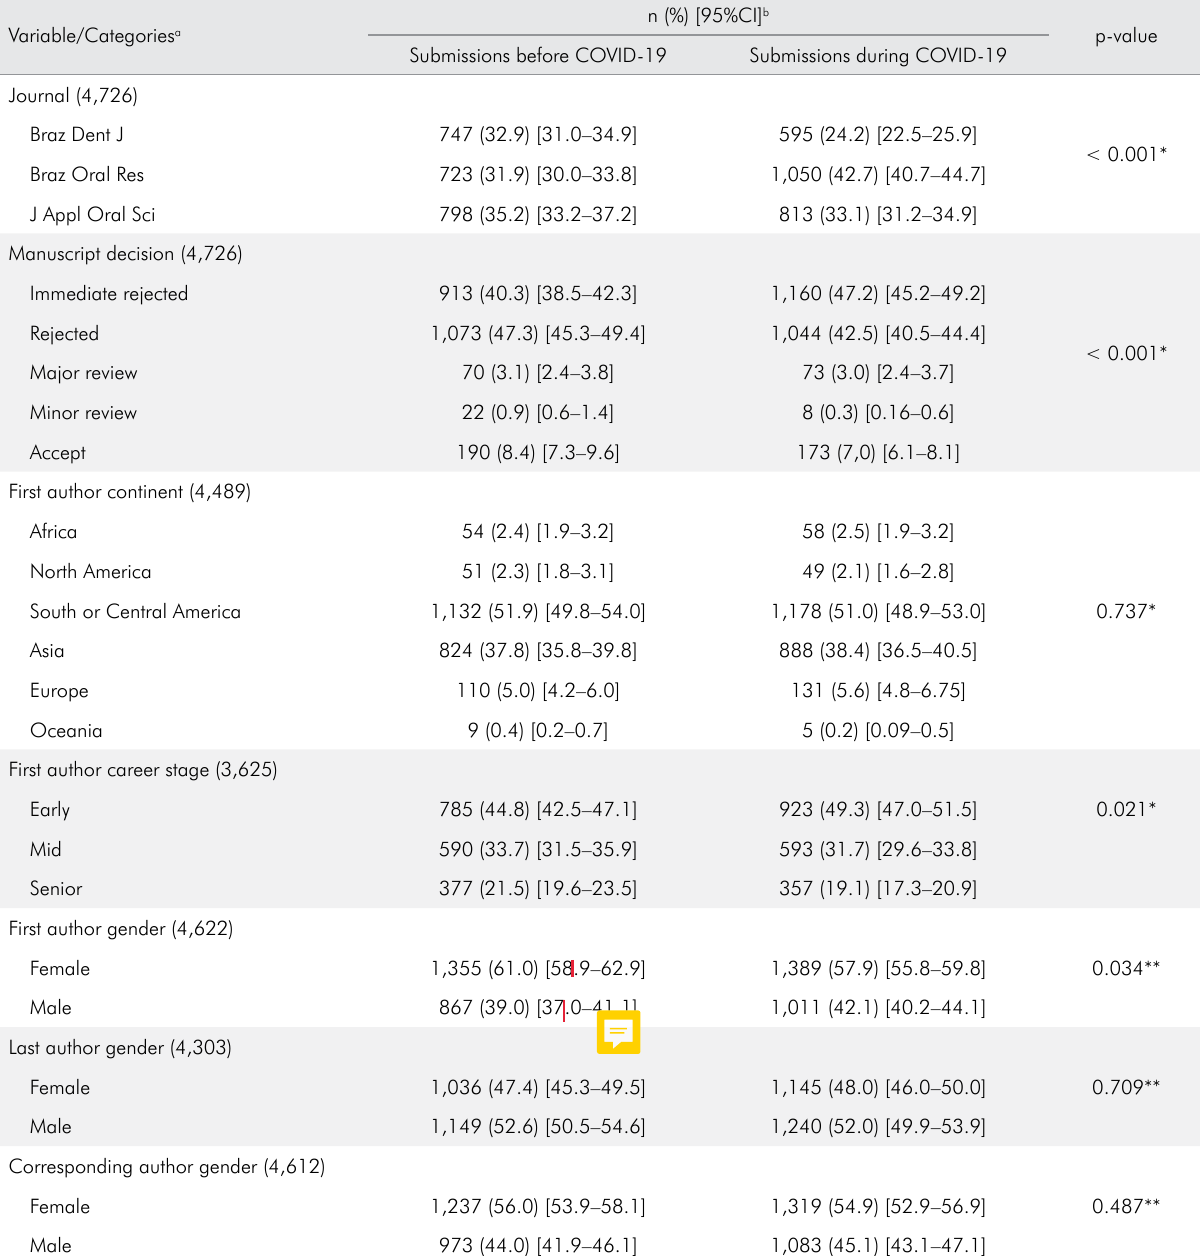
Table 1. Number of submissions according to journals, author variables, and period (before or during the pandemic), n = 4,726. Variable/Categories